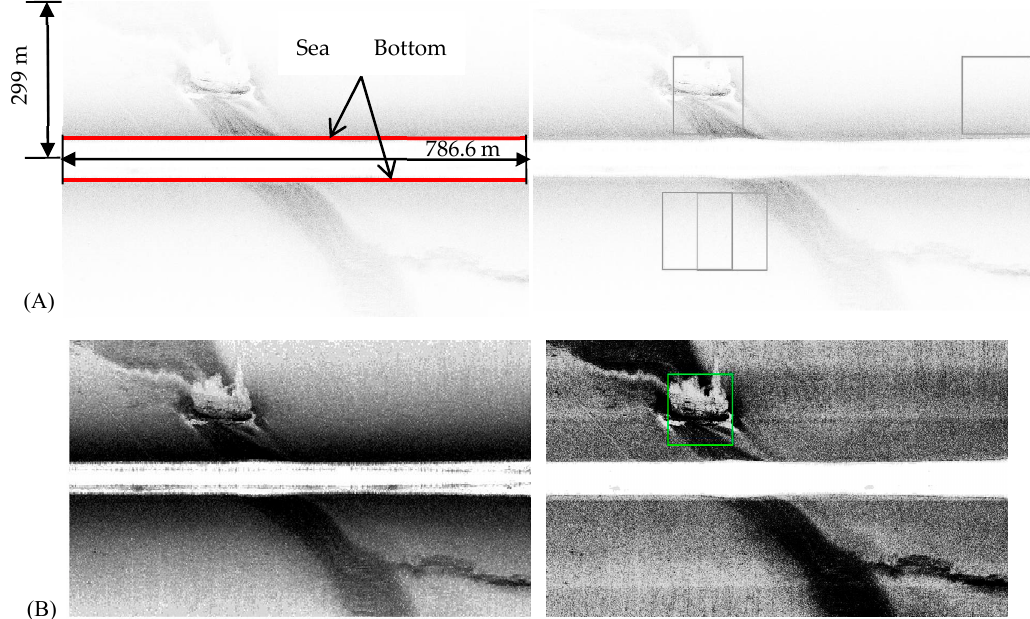
Figure 9. The shipwreck target recognition result in area I. ( A ) The raw SSS image is used for the experiment; ( B ) The radiation distortion corrected image is used for the experiment.